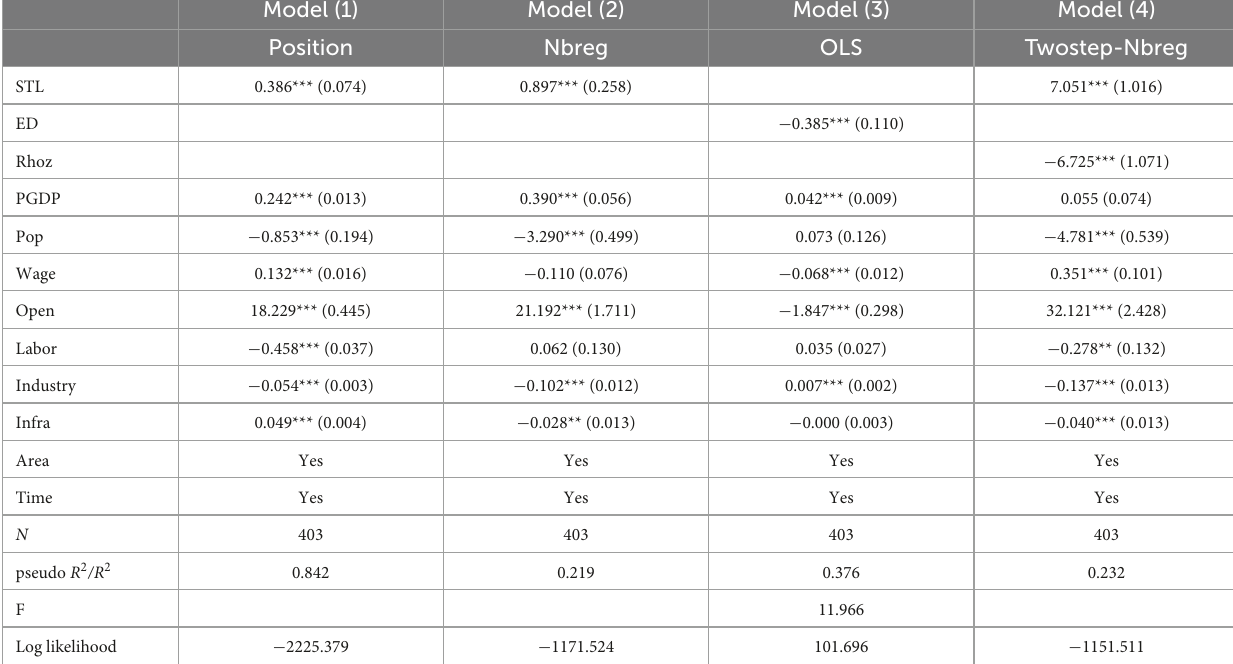
TABLE 5 Regression results of the instrumental variable